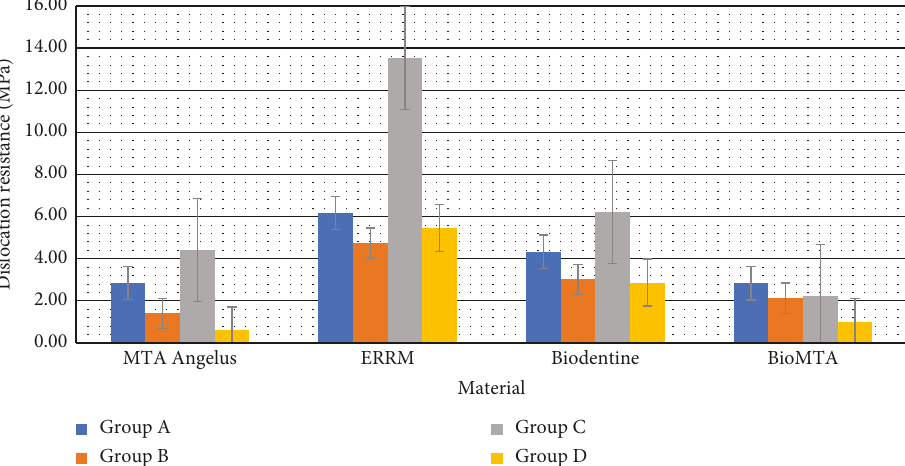
Figure 7: Mean dislocation resistance (MPa) of repair materials after storage in designated subgroups. ERRM, MTA, and Biodentine show the highest MPa values in 34 days of storage in PBS (group C), whereas bioMTA shows the highest values in 4 days of storage in PBS (group A).